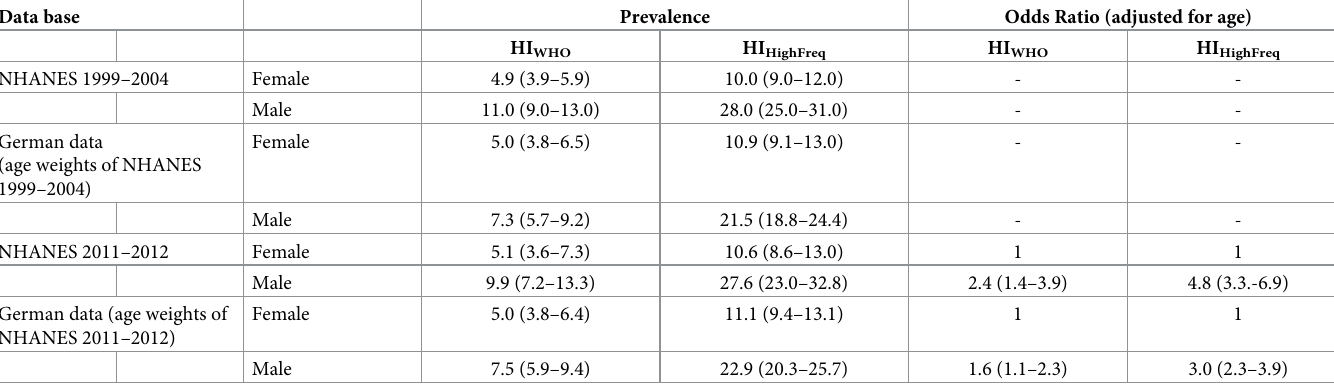
Table 3. Prevalence and risk for HI WHO and HI HighFreq in females and males aged 20 to 69 as reported for the US-American NHANES data and as replicated in the German sample. Data